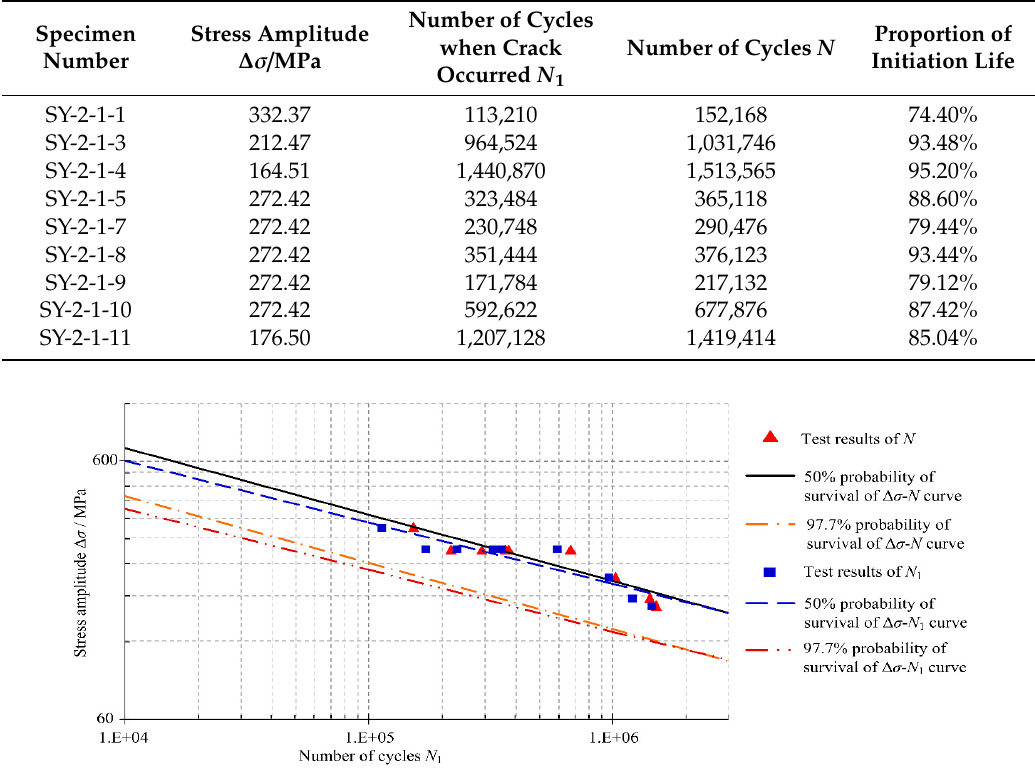
Figure 4. The comparison between the curves Δσ - N and Δσ - N 1 .